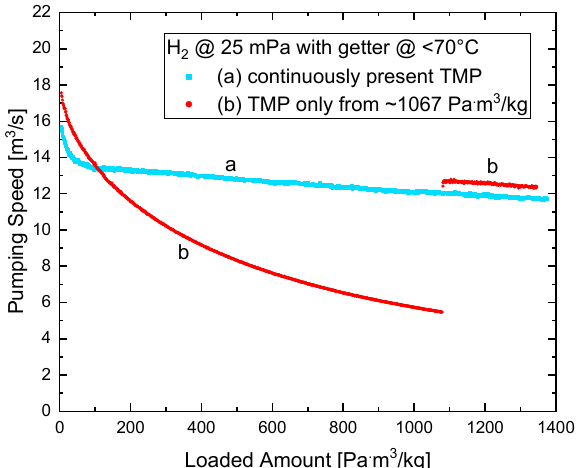
Figure 13. Pumping speed comparison between the normal experimental scheme with TMP present and a run without TMP, and the increasing pressure in TIMO due to background gas pressure rise. A full recovery of the pumping speed after such a non-ideal condition is demonstrated.